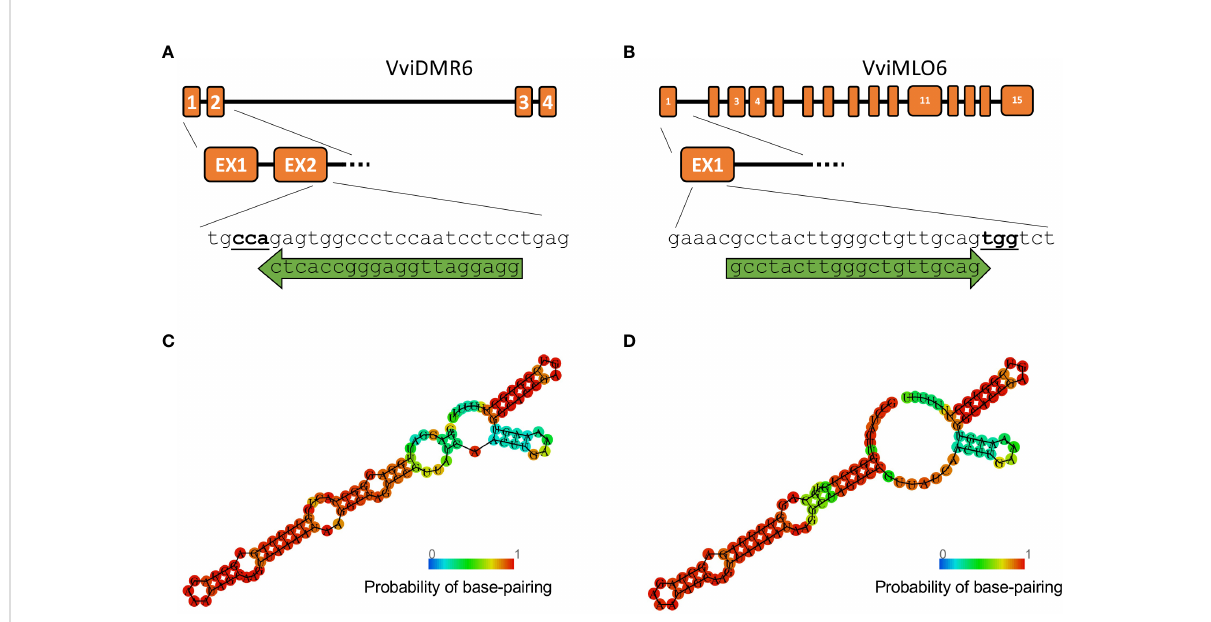
FIGURE 3 Guide RNA design. Gene structure of (A) VviDMR6 and (B) VviMLO6 with their respective guide RNA, indicated by green arrows. PAM sites are indicated in bold. A Minimum Free Energy (MFE) model was built for both guides (C, D) using the RNAfold online tool ((Gruber et al., 2008)) to verify their secondary